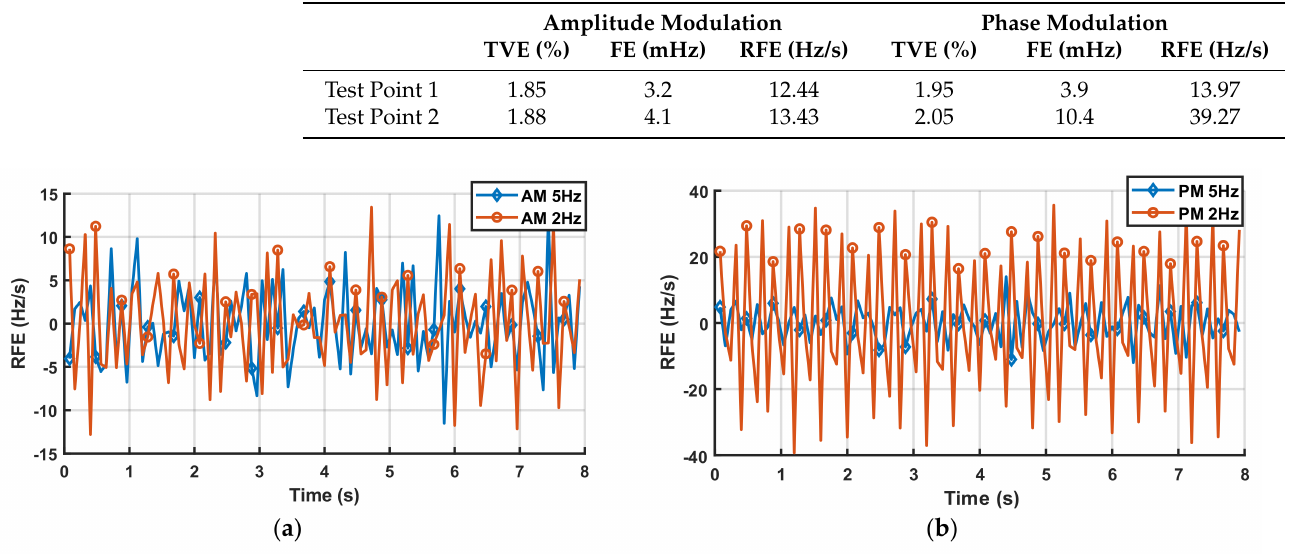
Figure 10. RFE of LPVT under test in amplitude ( a ) and phase ( b ) modulations with modulation frequency of 5Hz (rhombus markers) and 2Hz (circle